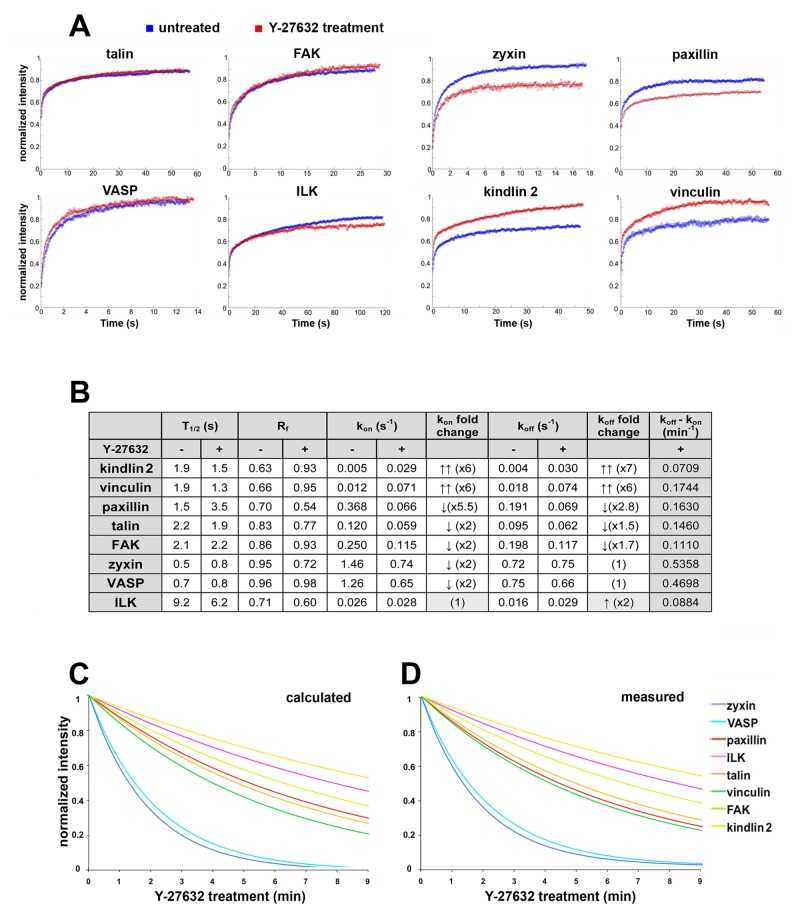
Dynamics of FA plaque proteins following Y-27632 treatment.(A) Normalized averaged FRAP curves (n=20-30) of FA plaque proteins in untreated and Y-27632 treated cells. For some proteins, no major changes were observed in the FRAP curves in untreated vs. treated cells (talin, FAK, VASP, ILK), whereas other proteins displayed higher (vinculin, kindlin-2) or lower (paxillin, zyxin) FRAP rates following Y-27632 treatment. (B) Kinetic parameters of FA proteins as derived from FRAP measurements within the first 9 min of Y-27632 treatment. The half-time to full recovery (T1/2) and mobile fraction (Rf) values of the FRAP curves prior to and following Y-27632 treatment were not indicative of the overall FA disassembly state. However, the differences between the kon and koff values derived from fitting the FRAP data to the full diffusion-exchange model represent the disassembly rate of FAs for each protein, following Y-27632 treatment. (C) Theoretical FA disassembly curves calculated from the differences in the expected disassembly rates of tested proteins from the FRAP data. (D) Actual disassembly curves measured directly from time-lapse movies, following treatment of HeLa JW cells with Y-27632. Note the remarkable similarity between the calculated and measured values.